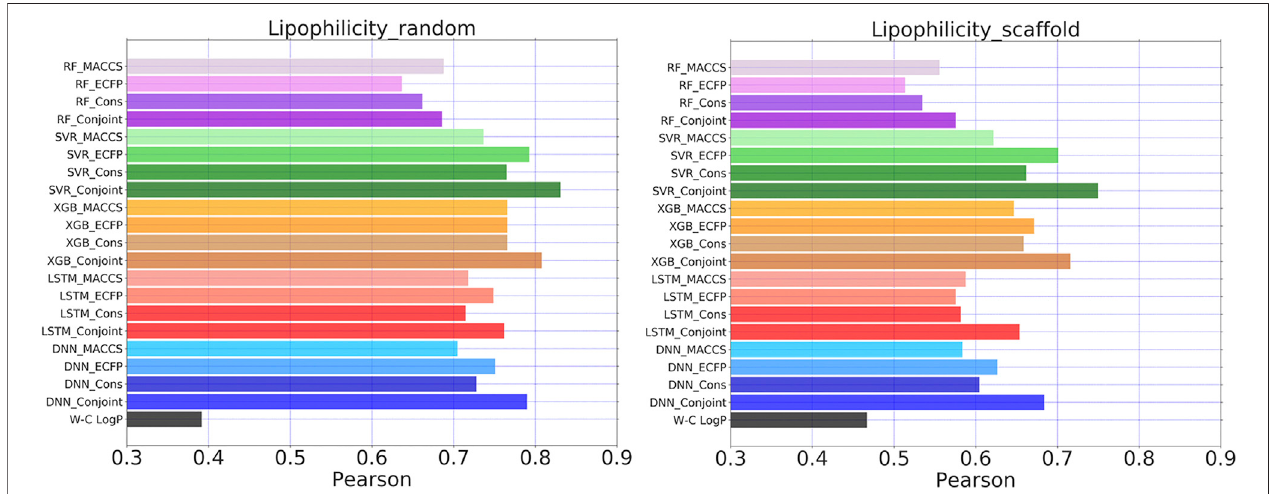
FIGURE 8 | Pearson coef fi cients for Lipophilicity dataset calculated by fi ve learning algorithms using MACCS keys, ECFP, consensus model and the conjoint fi ngerprints. The similar set of color represents one learning algorithm using different molecular fi ngerprints. Wildman-Crippen logP labeled as W-C logP.